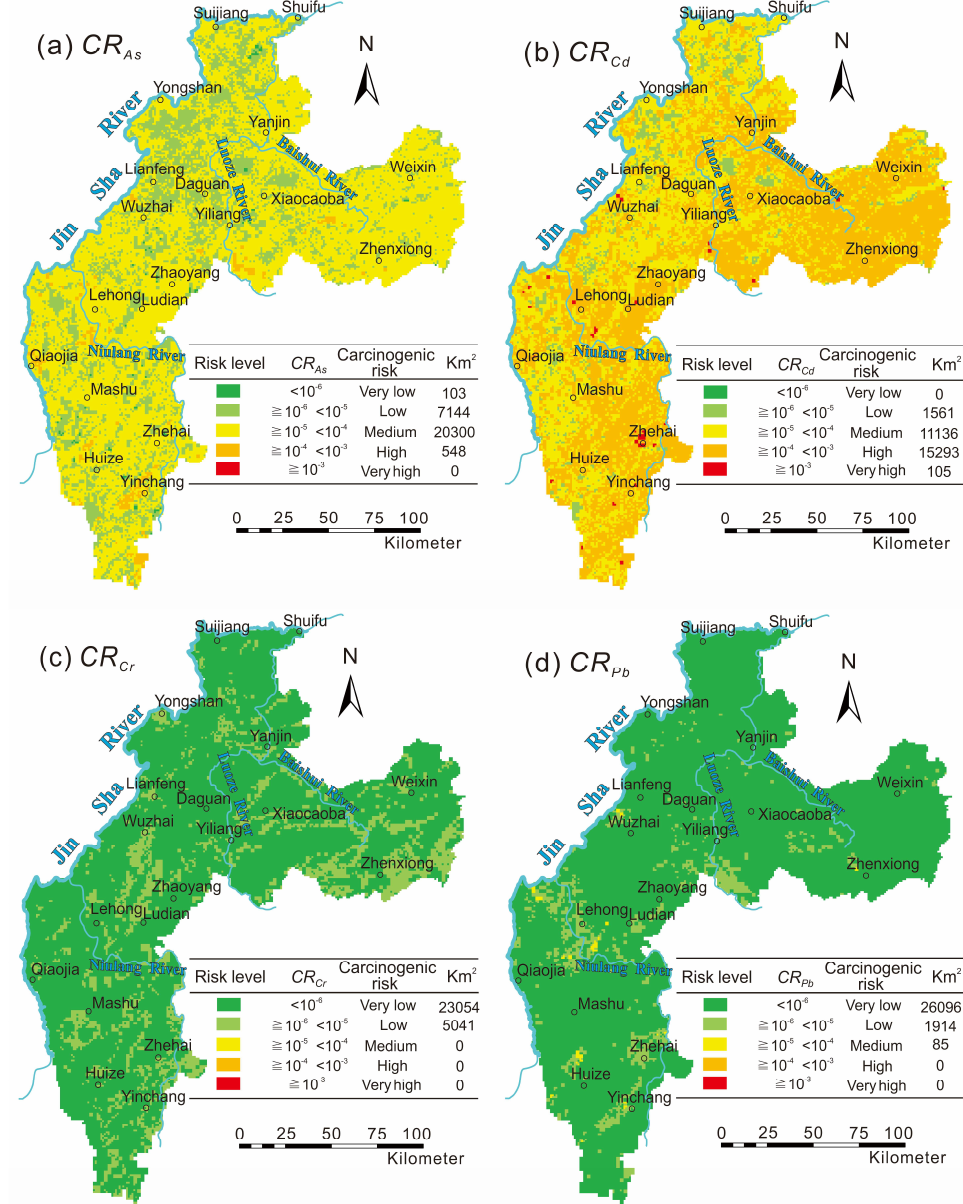
Figure 6. Spatial distribution of carcinogenic risk ( CR ) upon exposure to residents in the study area. ( a ) CR As , ( b ) CR Cd , ( c ) CR Cr , ( d ) CR